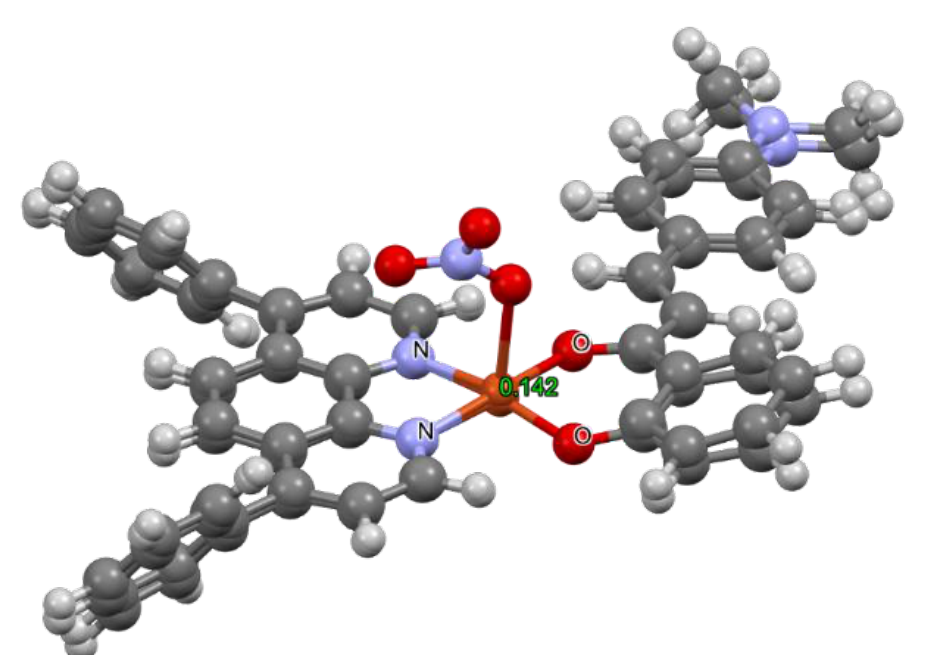
Figure 2. An overlay of the DFT optimized geometries of the [Cu(bphen)(L)(NO 3 )] ( 2 ) and [Cu(bphen)(L)] + species in the water solvation model through the N 2 O 2 donor atoms, showing the separation of the Cu(II) atoms of 0.142 Å. The color coding of the atoms is as follows: hydro- gen atom − light gray, carbon atom − dark gray, nitrogen atom − blue, oxygen atom − red, copper